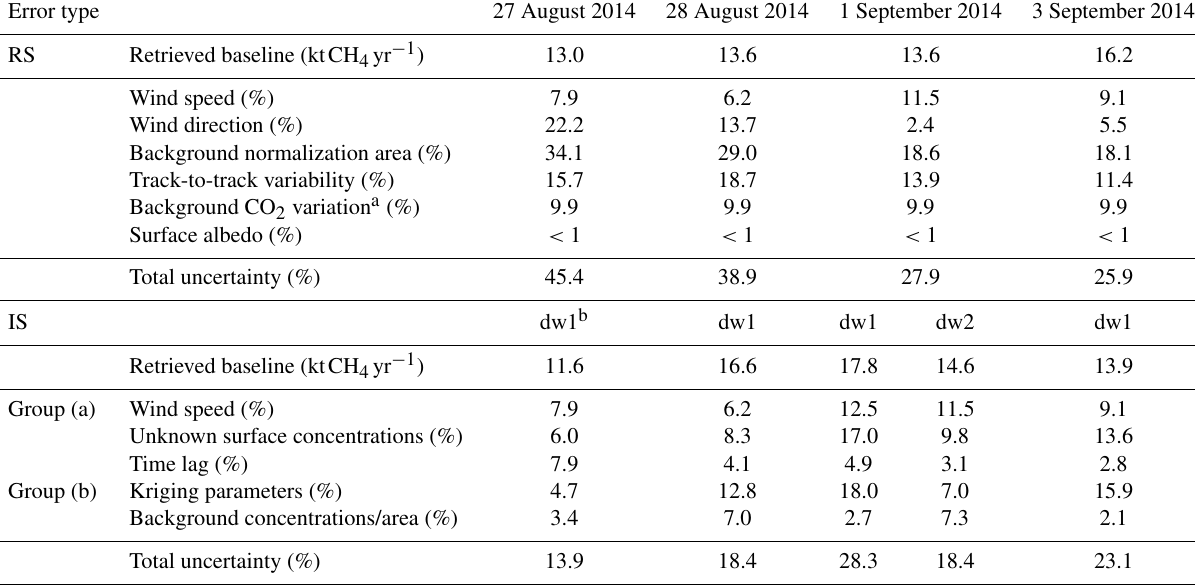
Table 2. Summary of the derived emission rates denoted as “retrieved baseline” and their related relative errors from the remote sensing (RS) and in situ (IS) data set of the Olinda Alpha Landfill